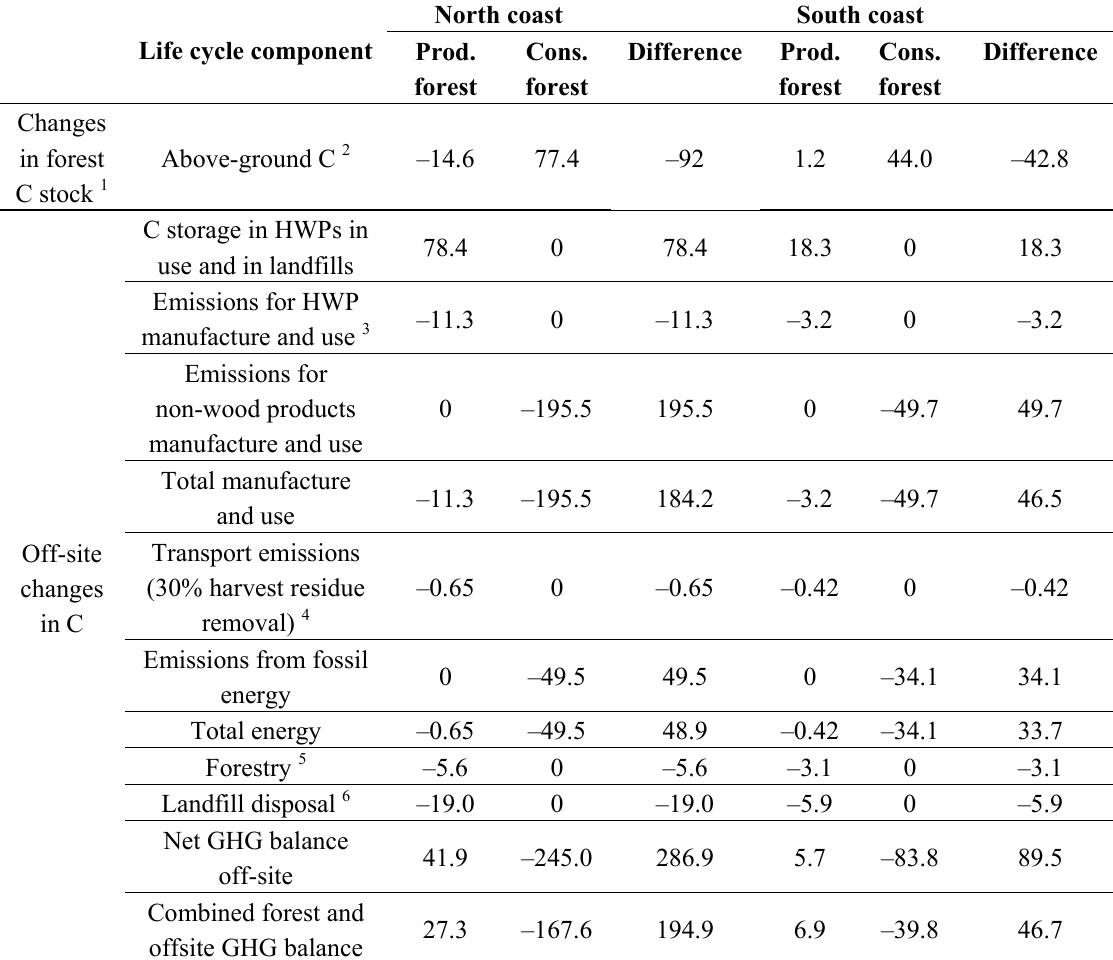
Table 8. GHG mitigation (t C ha − 1 ) for significant components of the forest and product life cycle under “ production ” (prod.) and “ conservation ” (cons.)